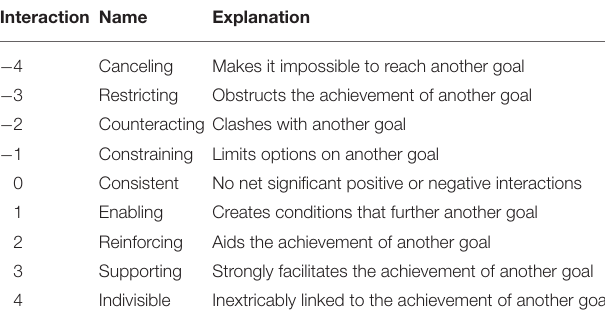
TABLE 1 | Categories for defining interaction values between